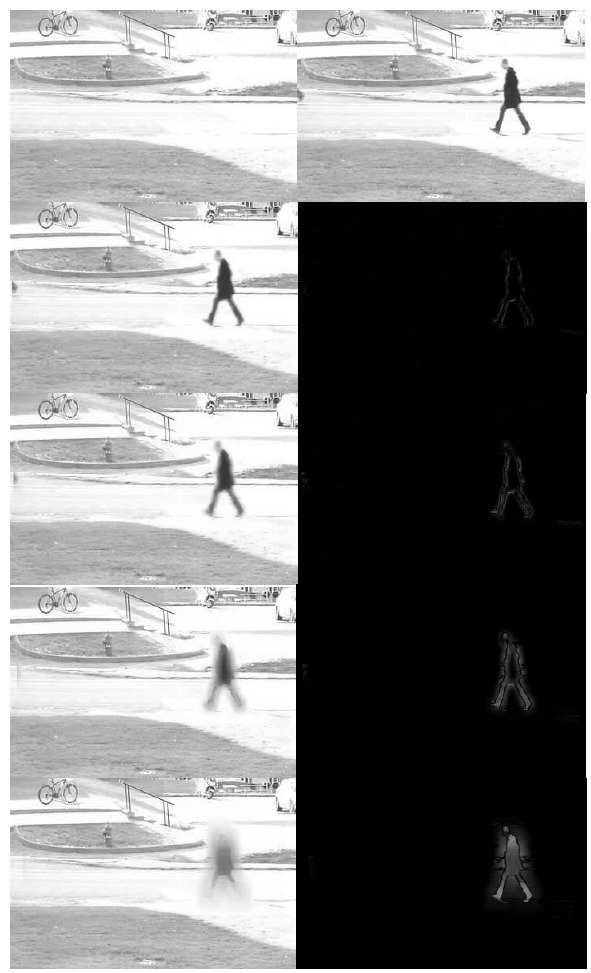
Figure 1. Comparative filtration with different window sizes. 1 st row from left to right: background model (template image f ) and image with object (test image g ). 2 nd row: filtered test image  f ( g ) and detected relative changes ∆ g f , i.e. difference between filtered test image and test image, window size is 4×4. 3 rd row: the same as 2 nd row, window size is 8×8. 4 th row: the same as 2 nd row, window size is 16×16. 5 th row: the same as 2 nd row, window size is